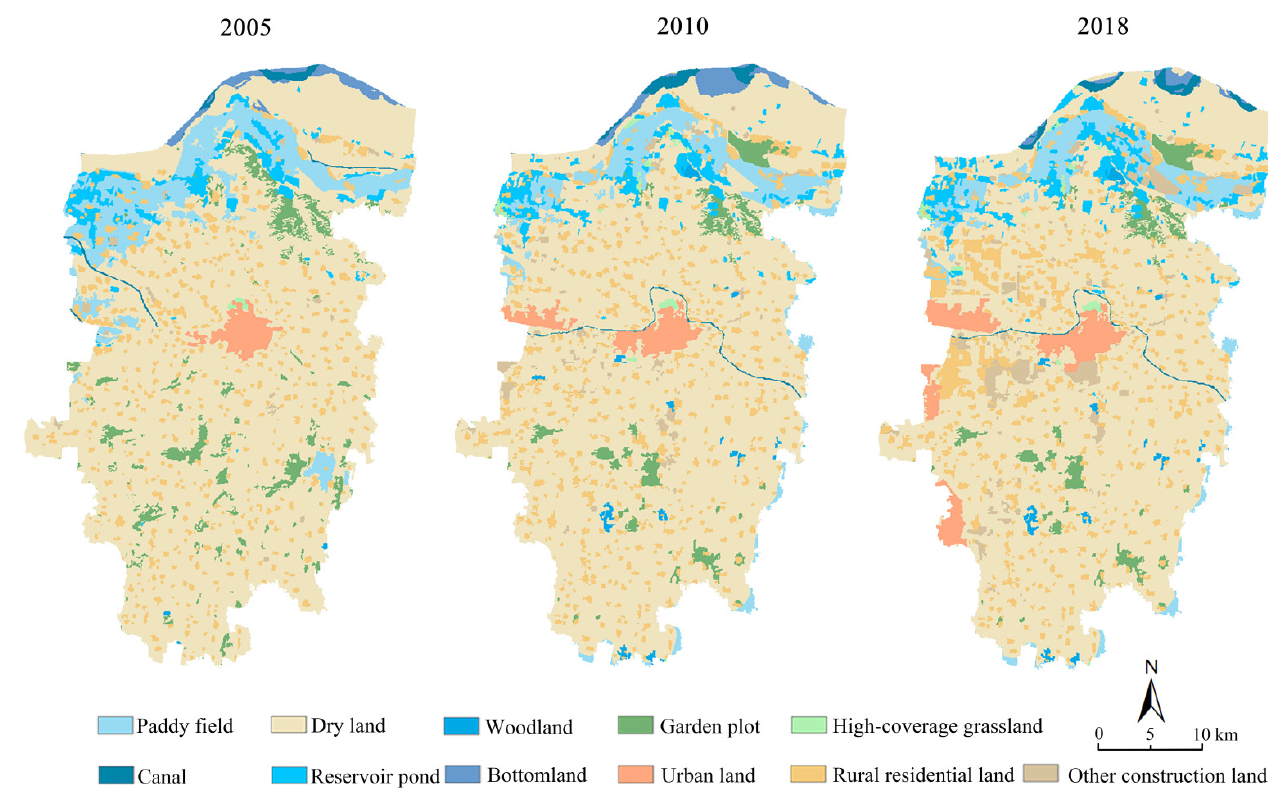
Figure 2. Landscape classification map of Zhongmu County.